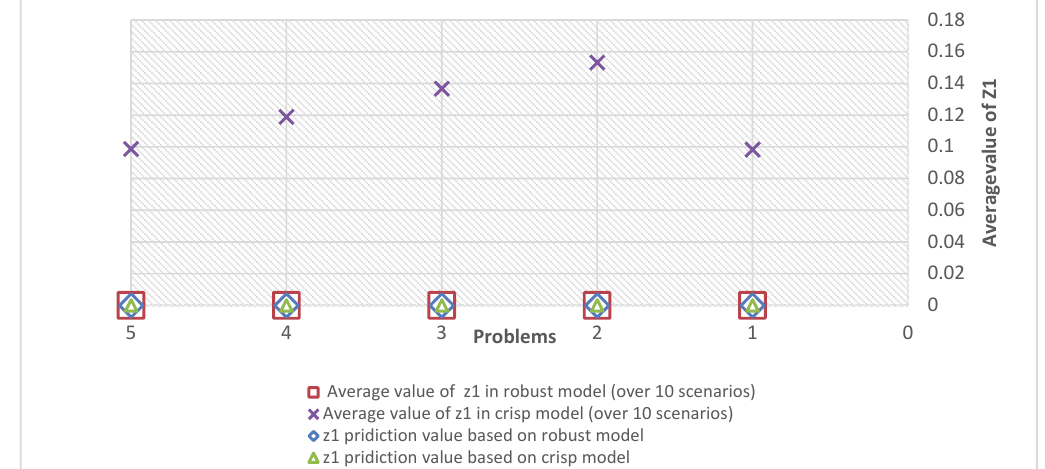
Fig. 2. Evaluation of the first objective-function (z1) for both deterministic and robust models in five test problems